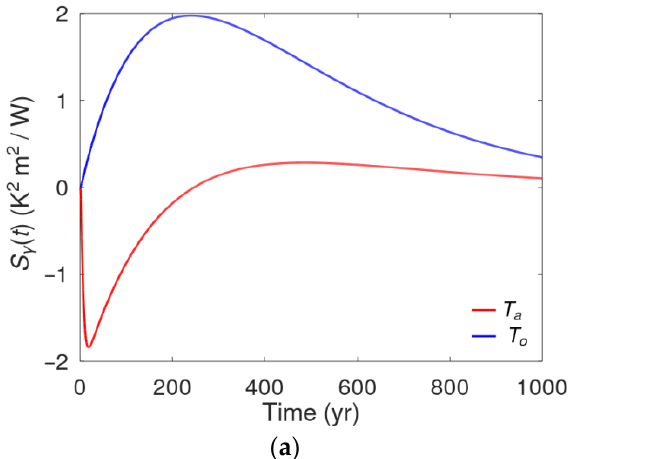
Figure 4. Sensitivities of global mean surface temperature (red line) and global mean deep ocean temperature (blue line) with respect to parameter 𝛾 , calculated for step-forcing: ( a ) over time inter- val of 0–1000 years, ( b ) over time interval of 0–2000 years.